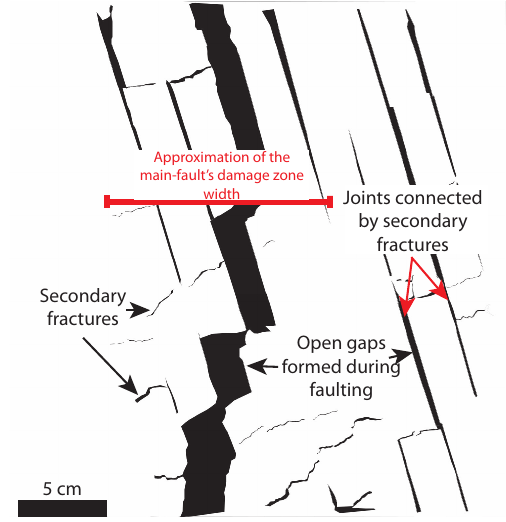
Figure 10. Top-view image of interpreted newly opened fractures at maximum displacement, exemplary of the 16 ◦ JF-angle experiment. Image shows the interpretation routine for estimating damage zone width, secondary fractures, joints connected by secondary fractures and open gaps formed during faulting. Photos and interpretations for all experiments are shown in the Appendix.